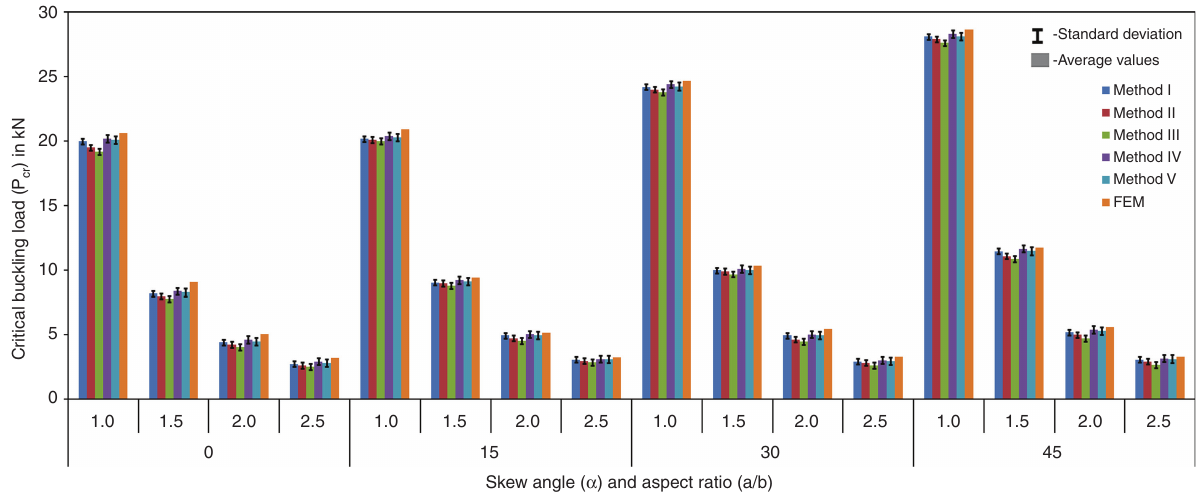
Figure 6 Critical buckling load for isotropic skew plate (aluminum